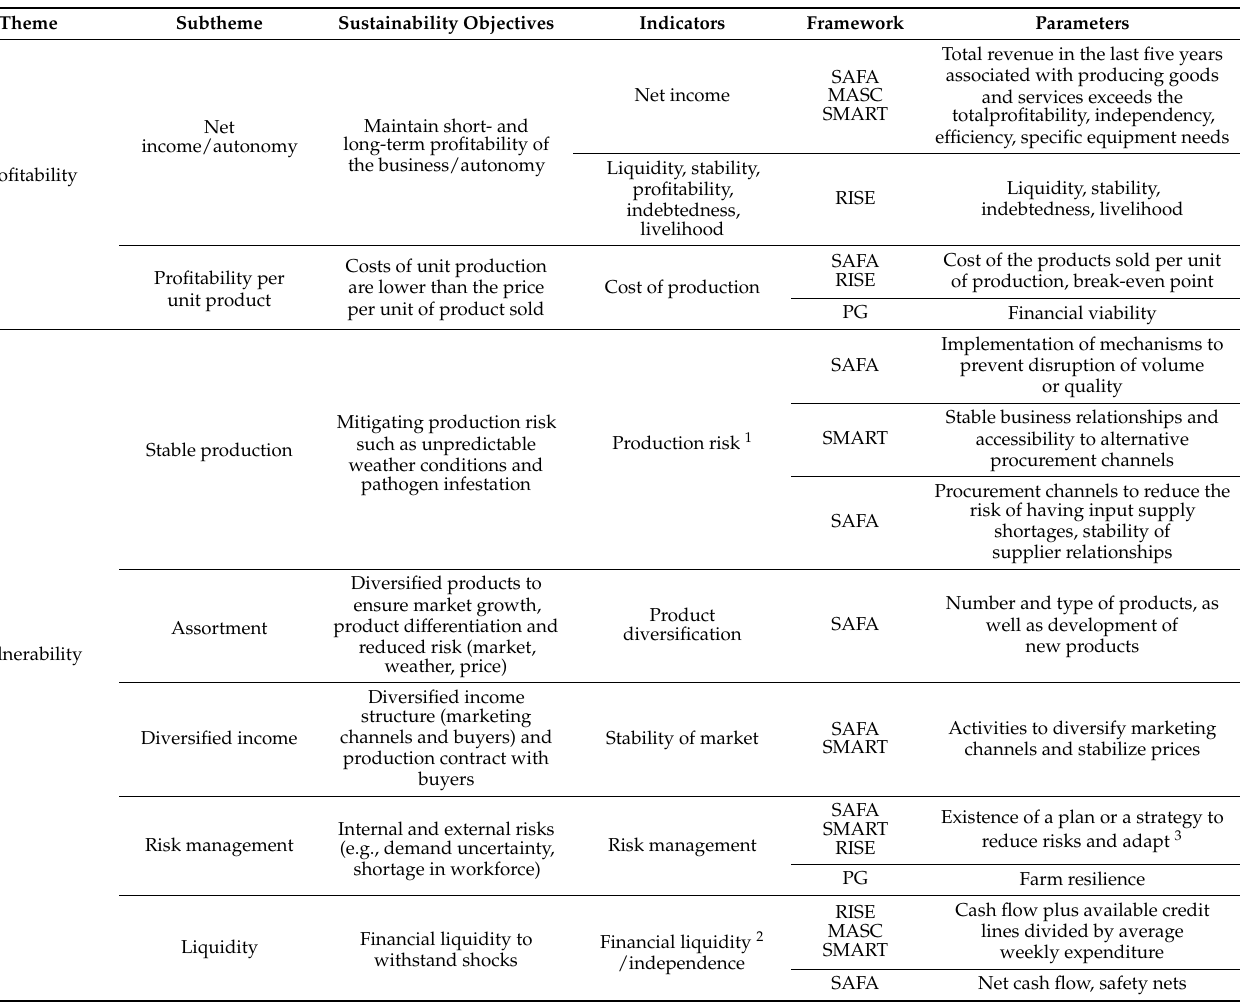
Table 4. Economic themes, sustainability objectives, indicators and measured parameters for each framework considered in his